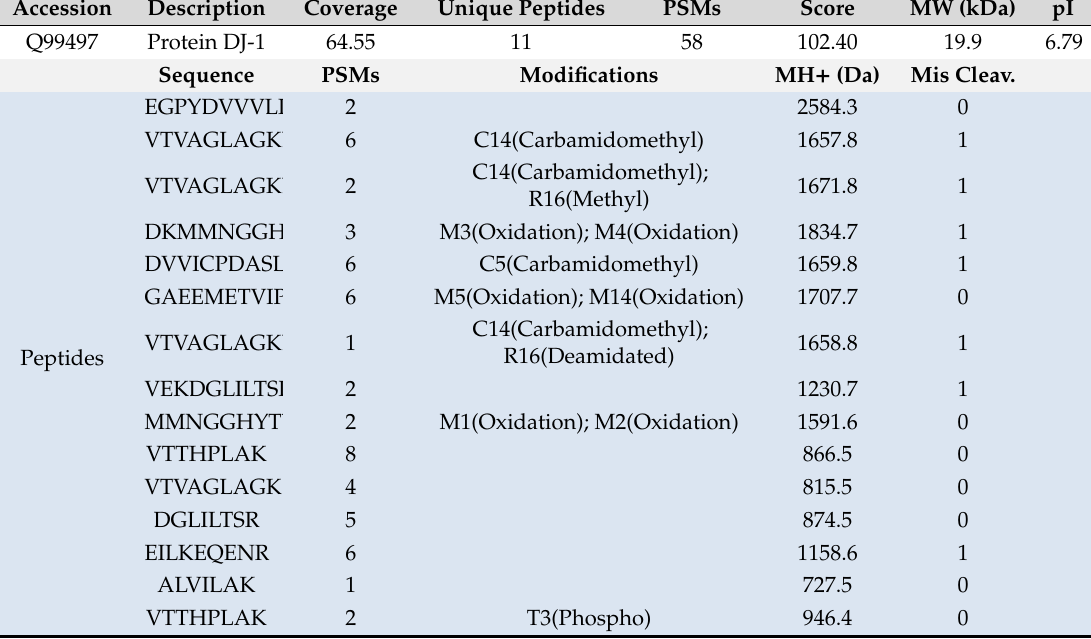
Table 3. Mass spectrometry analysis confirms that DJ-1, interacting with histones, carries a peculiar phosphorylation on Threonine included in the Akt consensus. In the table are: Accession number, Univocal code identifying the protein on the Uniprot database (https: // www.uniprot.org); Description of identified protein; Coverage, percentage of amino acid identified by MS / MS analysis; Unique peptides, number of peptides uniquely identifying the protein; PSMs, total number of identified peptide spectra matched for the protein; Score of identification; MW, molecular weight of identified protein; Calc pI, theoretical isoelectric point of identified protein; Sequence of identified peptide; PSMs, total number of identified peptide spectra matched for the peptide; Modification, position of modified residue and type of modification; MH + Molecular weight of positive ion; Miss cleavage, number of allowed missed cleavages. White row is referred to protein MS data. Blue rows are referred to peptide MS